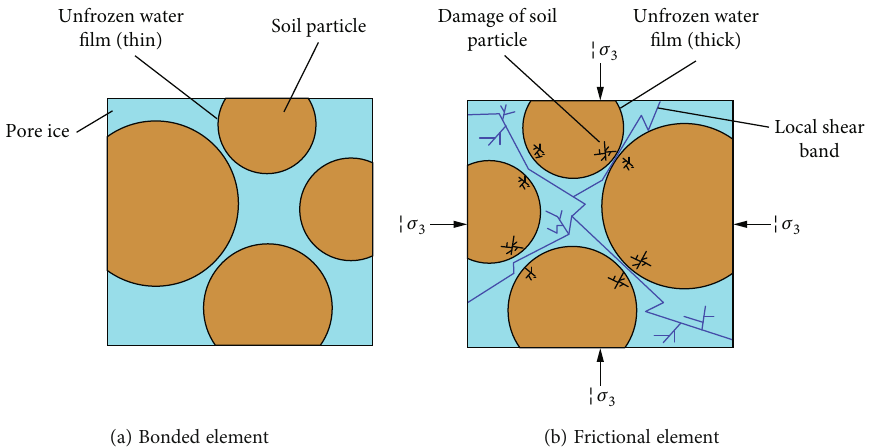
Figure 6: Structural model of saturated frozen